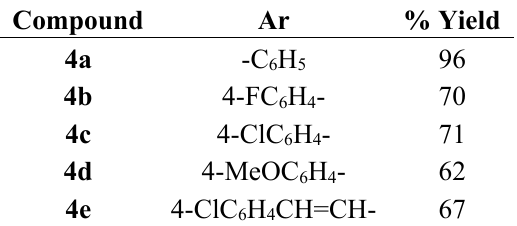
Reagents and conditions : (i) ArB(OH) 2 (2.5 equiv.), PdCl 2 (PCy 3 ) 2 , K 2 CO 3 , DMF-ethanol (3/1; v/v), reflux, 4